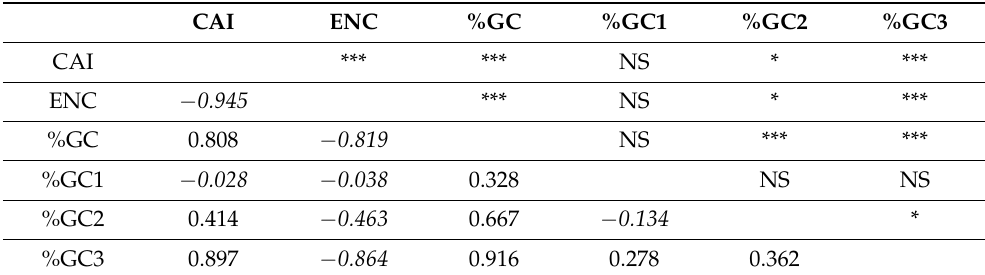
Table 2. Correlation analysis between overall GC composition and GC composition at all the three codon positions along with CAI and